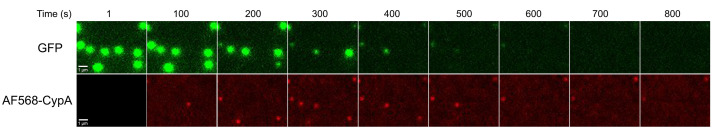
Capsid uncoating assay via painting with CypA.
Snapshot images from a time series of viral particles recorded in the GFP channel (content marker, top) and the AF568 channel (CypA paint, bottom) at 1 frame per second. Snapshots correspond to indicated time points from the experiment shown in Video 2. Scale bars = 1 μm.